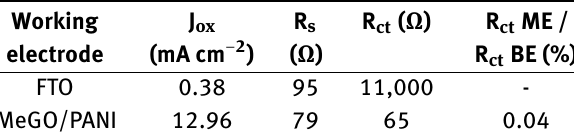
Table 1: Important parameters of modifying FTO electrode step by